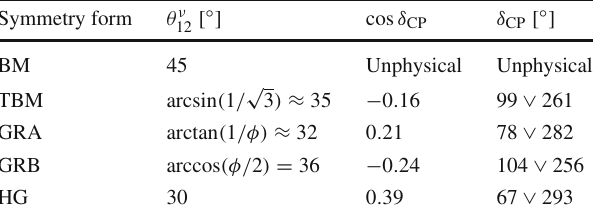
Table 2 The best fit values of cos δ CP and δ CP from the sum rule in Eq. (1.1) for the different symmetry forms. The mixing angles θ 12 , θ 23 , and θ 13 have been fixed to their NO best fit values from Table 1. The φ +√ stands for the golden ratio: φ = ( 1 5 )/ 2. See text for further details Symmetry